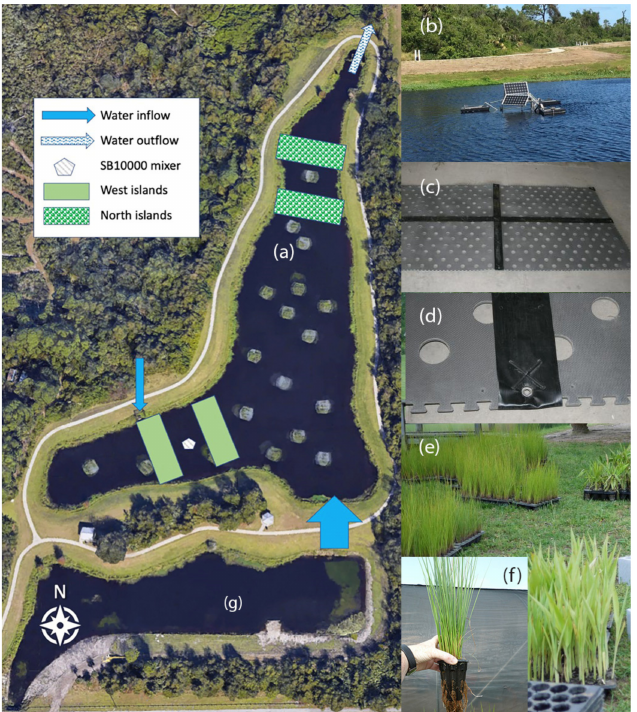
Figure 1. Graphic detailing ( a ) the 19 individual Beemats floating wetlands deployed in the Wickham Park pond, near Melbourne, FL, USA from 2017 to 2018 (the small slightly blurred circles on the pond’s surface); also noted are the locations of the four, rectangular floating treatment wetlands (225 m 2 each) that were installed in March 2018; ( b ) SB10000 mixer installed on the pond and powered by solar panels; ( c ) four 1.2 m × 2.4 m solid core foam mats connected using nylon clips and washers, the seams covered by Permalon ® ; ( d ) close-up of Permalon ® strips and stainless-steel grommet used as anchor points; ( e ) Juncus effusus (left rear) and Canna flaccida (right front) plants in trays ready for installation in the floating treatment wetlands; ( f ) plastic aerator cup with Juncus effusus plant, about two weeks after planting; and ( g ) the pond